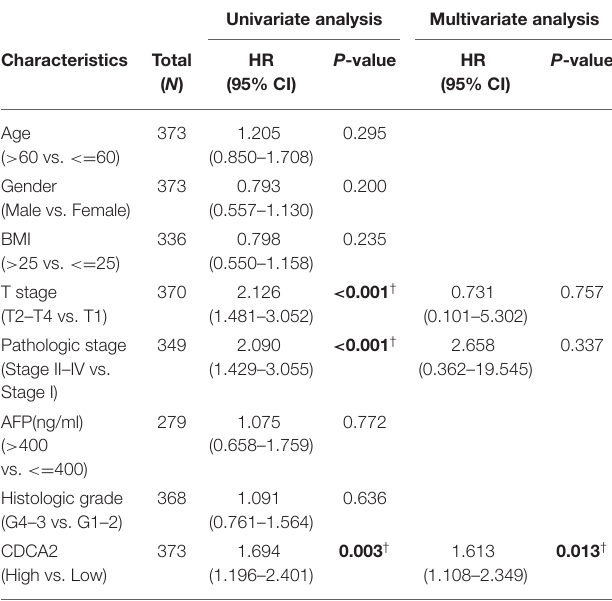
TABLE 2 | Univariate and multivariate analysis were used to estimate the correlation between clinicopathological characteristics and prognosis of hepatocellular carcinoma